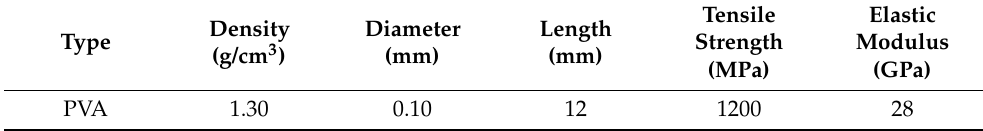
Table 2. Dimensions and mechanical properties of polyvinyl alcohol (PVA)